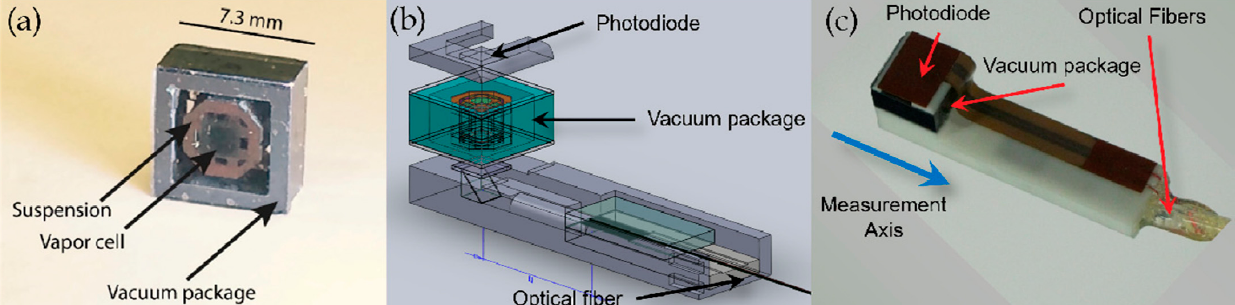
Figure 21. NIST OPM-micro-fabricated magnetometer for measuring brain magnetism (2017). ( a ) vapor cell, ( b ) Magnetometer schematic, ( c ) Magnetometer physical map. Reprinted from Ref [106]. In 2018, researchers at the University of Nottingham, UK, integrated a novel mobile magnetoencephalography device by utilizing a commercial SERF atomic magnetometer [108], as shown in Figure 22. The SERF atomic magnetometer was configured on the head of the subject for MEG testing by scanning the individual in 3D and customizing a 3D-printed helmet. The new mobile magnetoencephalography device is suitable for patients in various conditions and allows them to move freely while interacting with the real world.